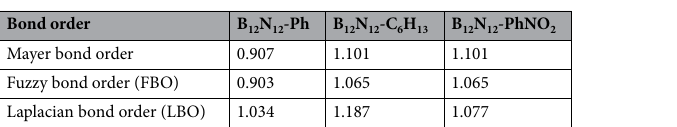
Table 4. Bond orders for the B–C atoms of the grafted